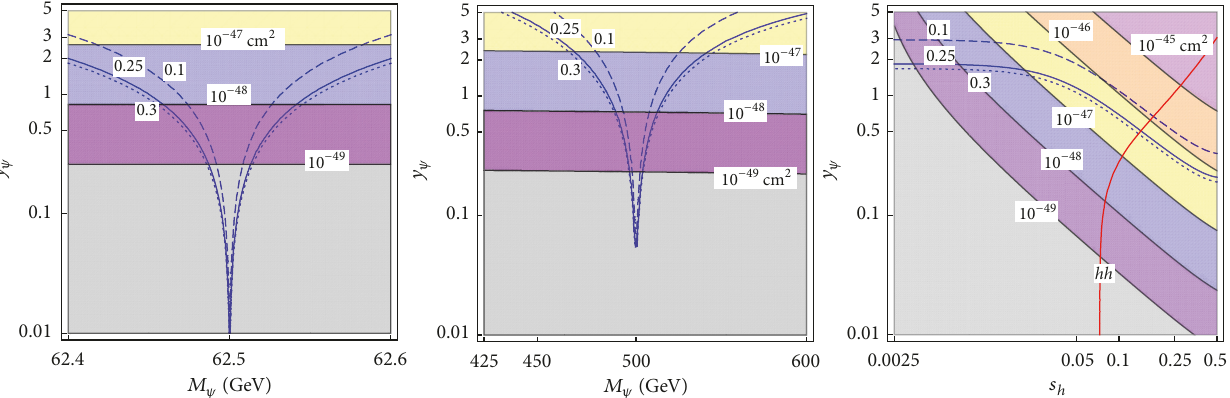
Figure 6: Same as in Figure 5 but with the parameters not varied along the axes fixed at 𝑦 푈 = 2.5 , 𝑠 ℎ = 0.01 , and 𝑀 휓 = 475 GeV. The thick red line shows the 8 TeV LHC ℎℎ channel